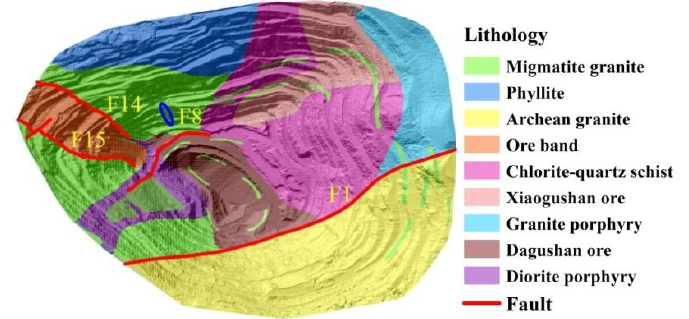
Figure 3. Distribution of faults and lithology in the Dagushan mining pit.